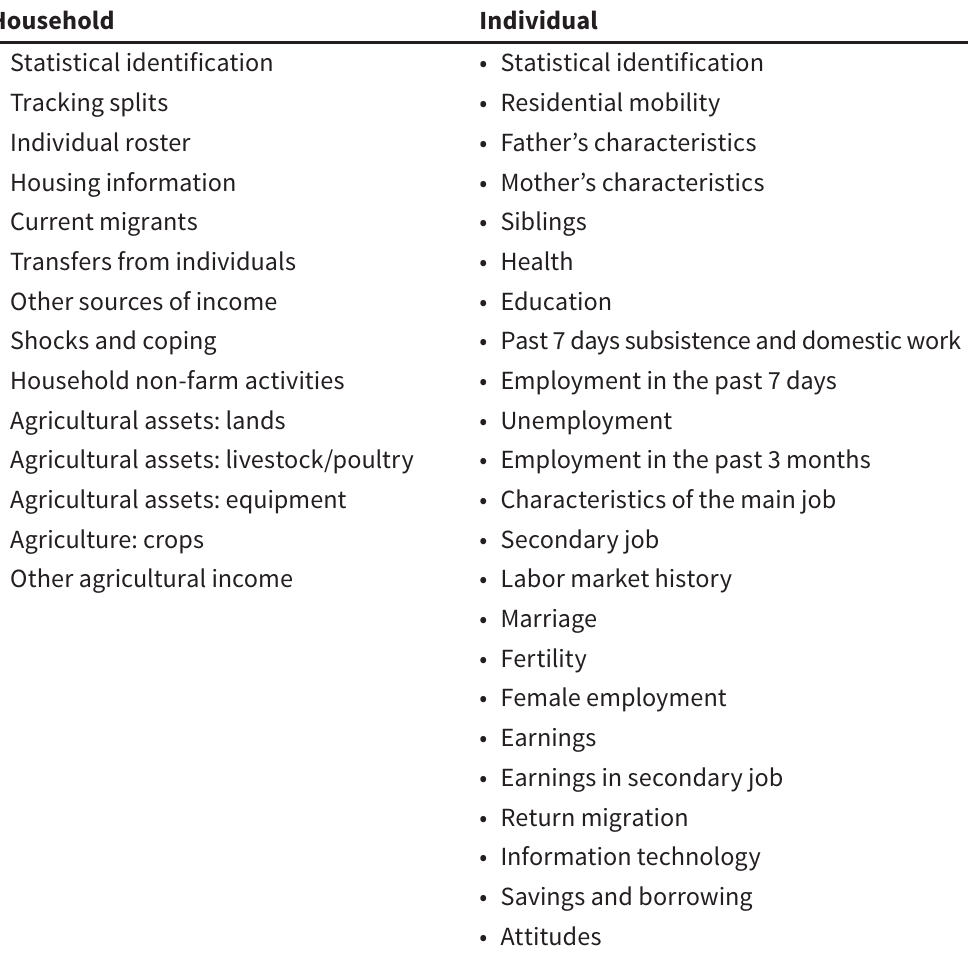
Questionnaire modules Household